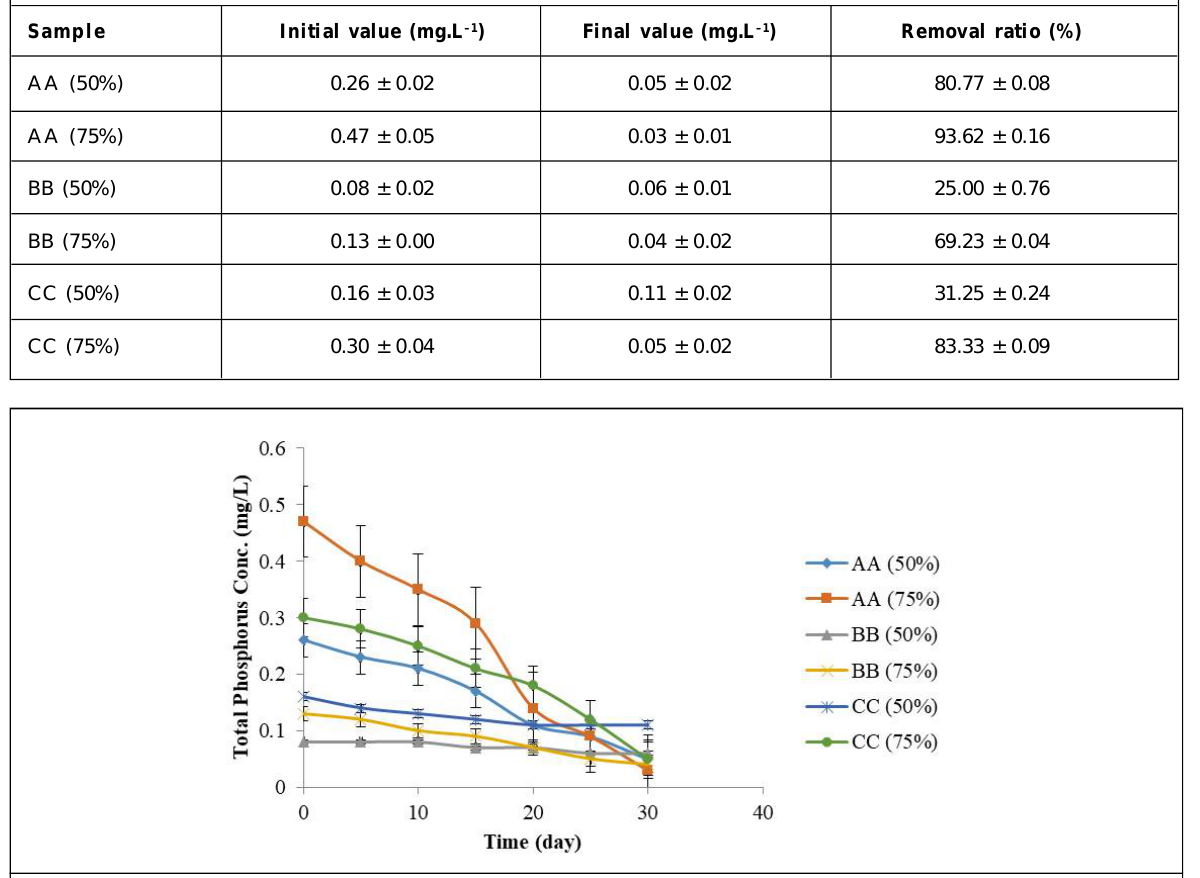
Figure 3.2: Graph of TP concentration in industrial wastewater and microalgae samples mixture AA, BB and CC at different proportions (50%, and 75%) for 30